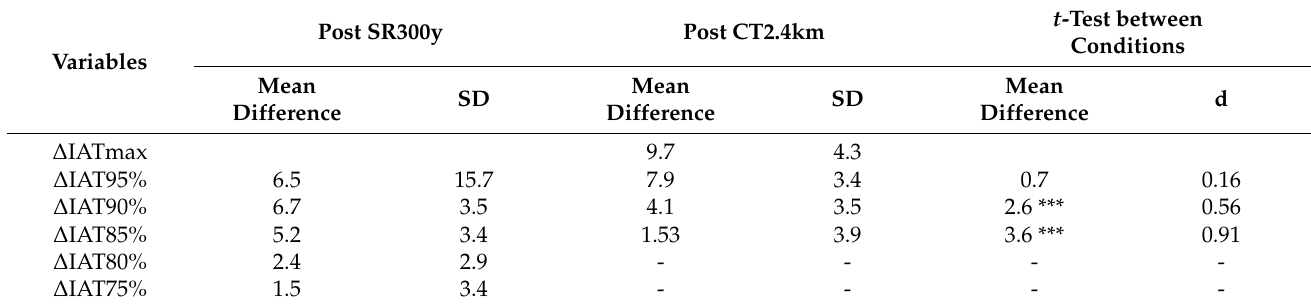
Table 3. Differences in effects obtained by SR300y and CT2.4km.